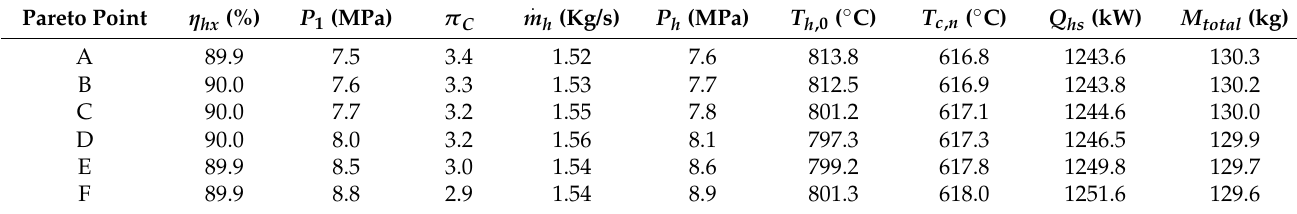
Table 6. System parameters of Pareto